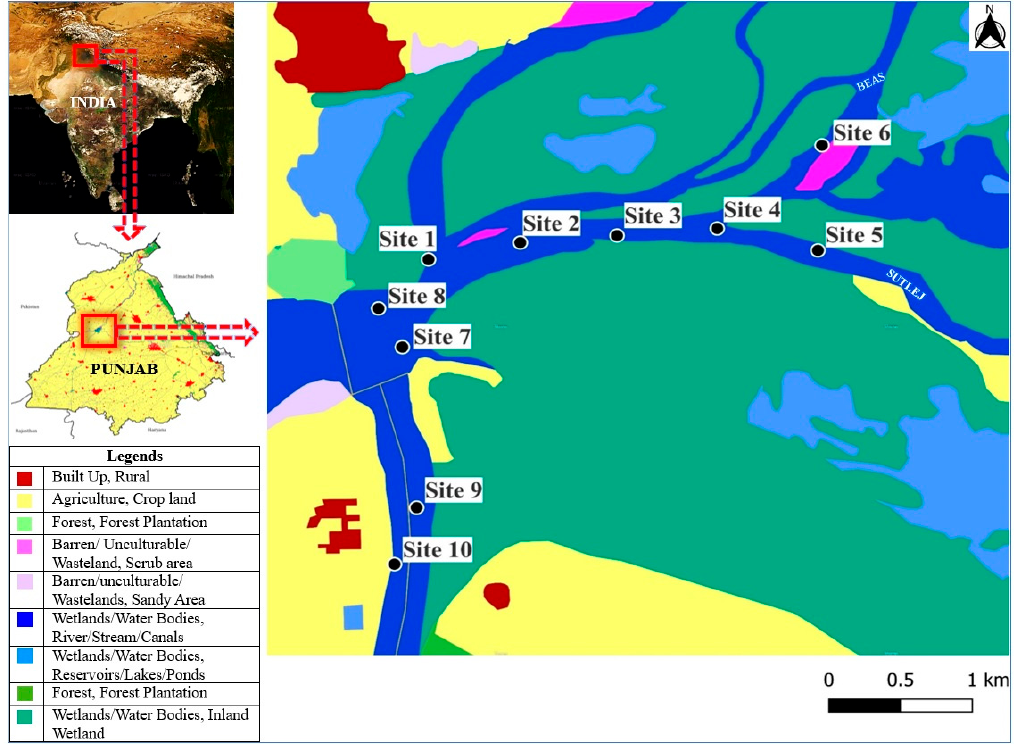
Figure 1. Study area map with sampling locations of the Harike wetland, Punjab, India. Source: https://bhuvan.nrsc.gov.in/home/index.php# (accessed on: 15 January 2021).